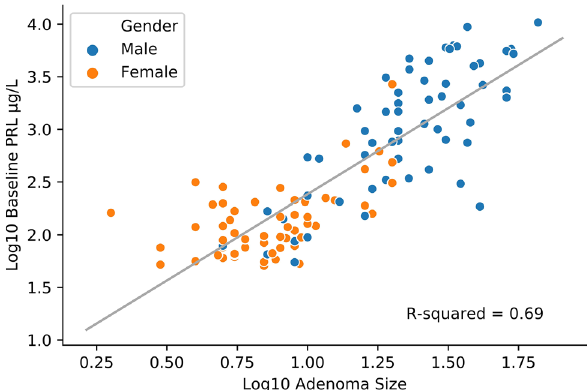
Figure 4. Correlation between baseline serum PRL concentrations and adenoma size—grouped by gender.